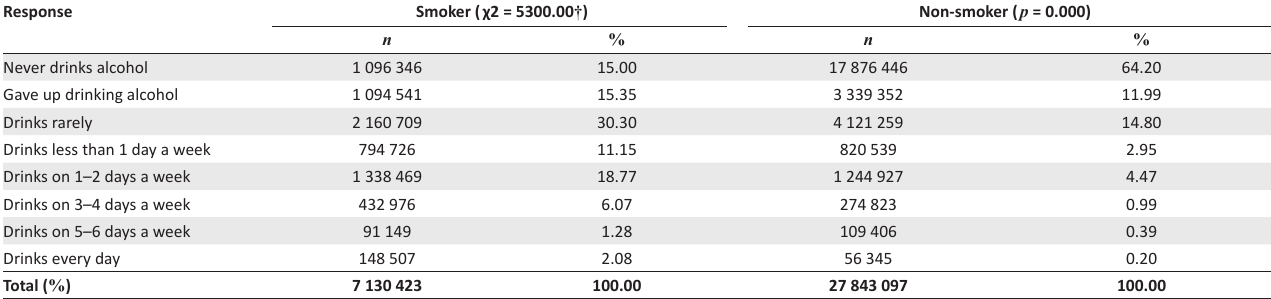
TABLE 7: Sensitivity analysis – Smoking and alcohol consumption (wave